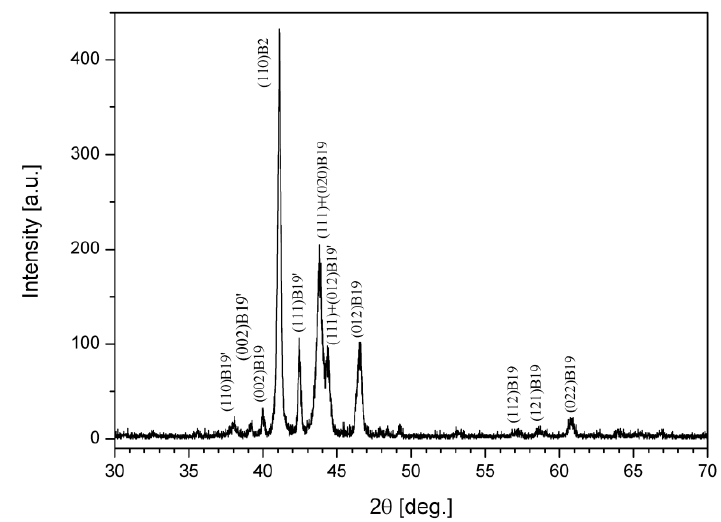
Figure 3. XRD record of the Ti-Ni-Cu target.